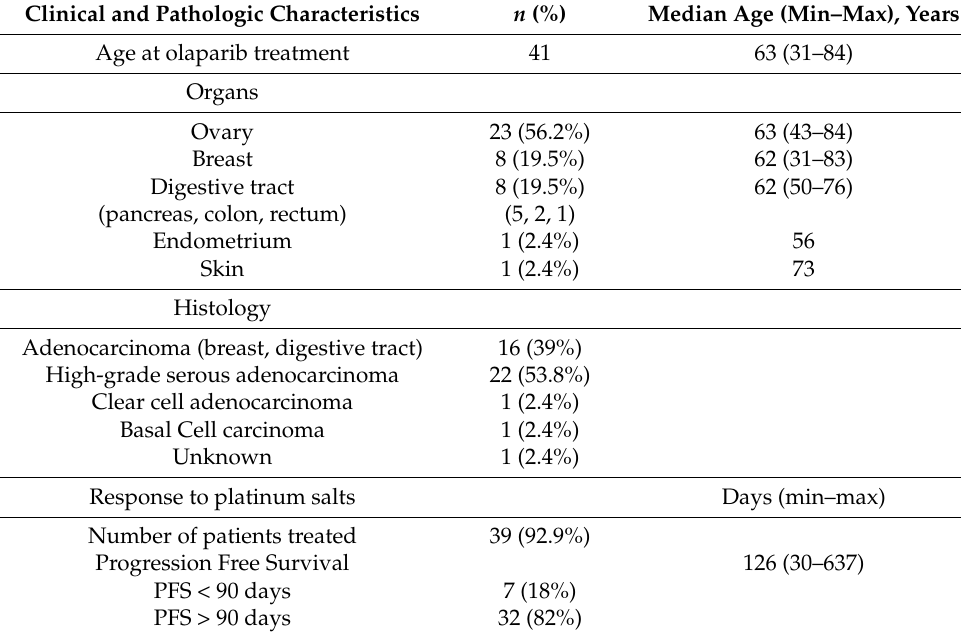
Table 1. Patient